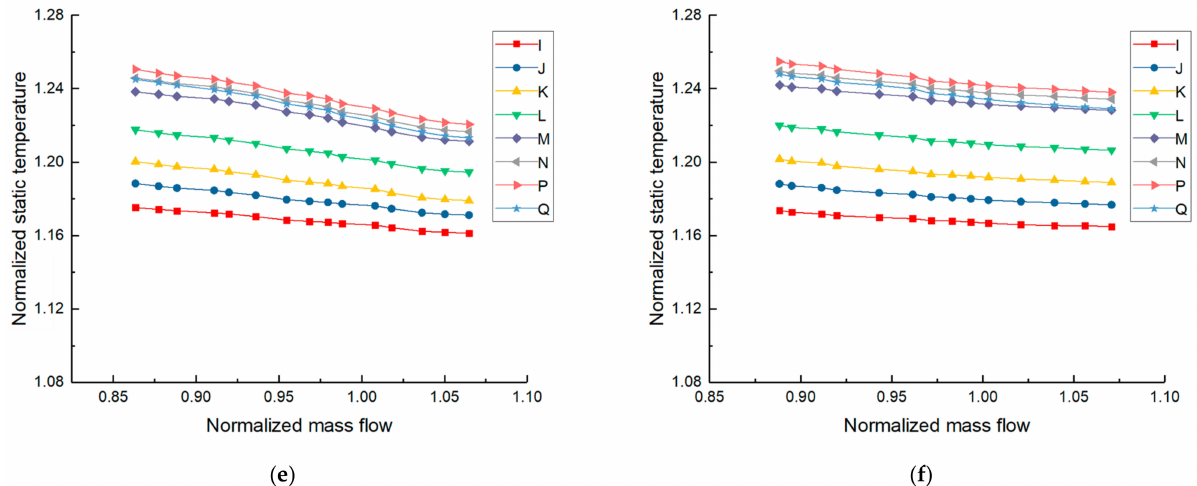
Figure 11. Characteristic curves of static temperature and its loss on the static wall of IBC under variable AVDs’ angles: ( a ) static temperature with − 8 ◦ AVDs; ( b ) static temperature with − 4 ◦ AVDs; ( c ) static temperature with 0 ◦ AVDs; ( d ) static temperature loss with variable AVDs’ angles; ( e ) static temperature with +4 ◦ AVDs; ( f ) static temperature with +8 ◦